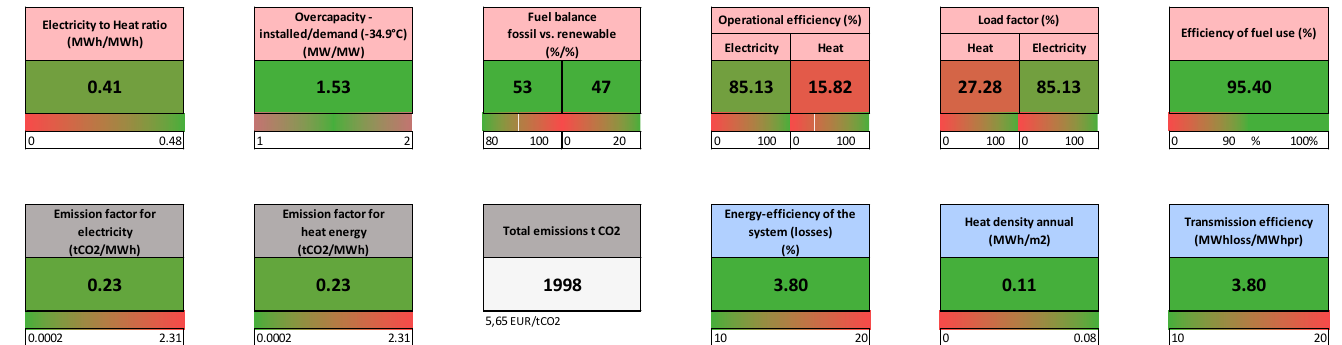
Figure 2. “Low refurbishment rate and low temperature supply” scenario criteria evaluation results. Additionally, all results for all scenarios are presented in Table 3. Table 3. Summary of results for simulation of all scenarios.